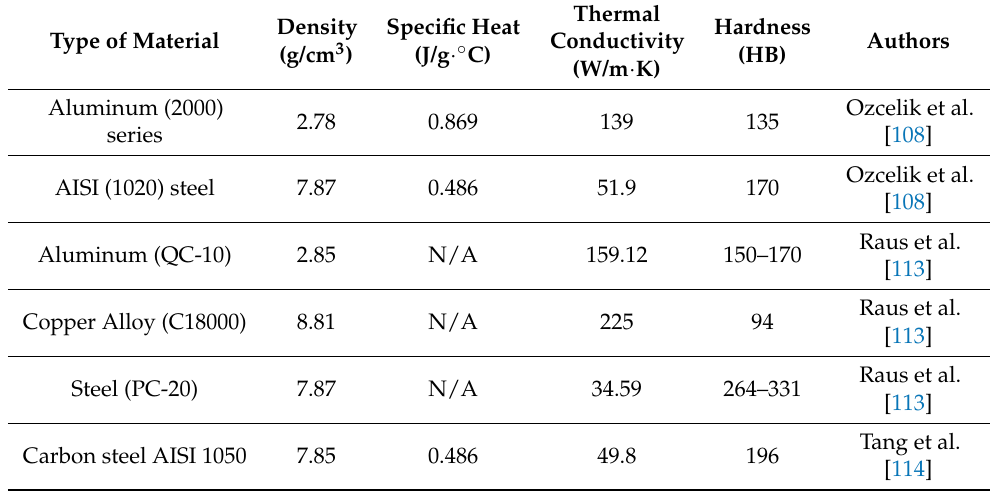
Table 2. Physical and mechanical properties of mold base